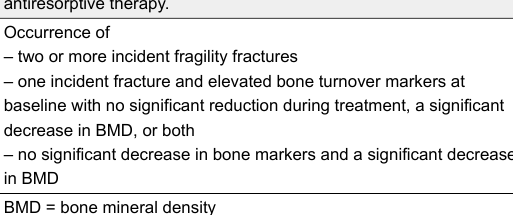
Table 1: Circumstances defining treatment failure in patients on antiresorptive